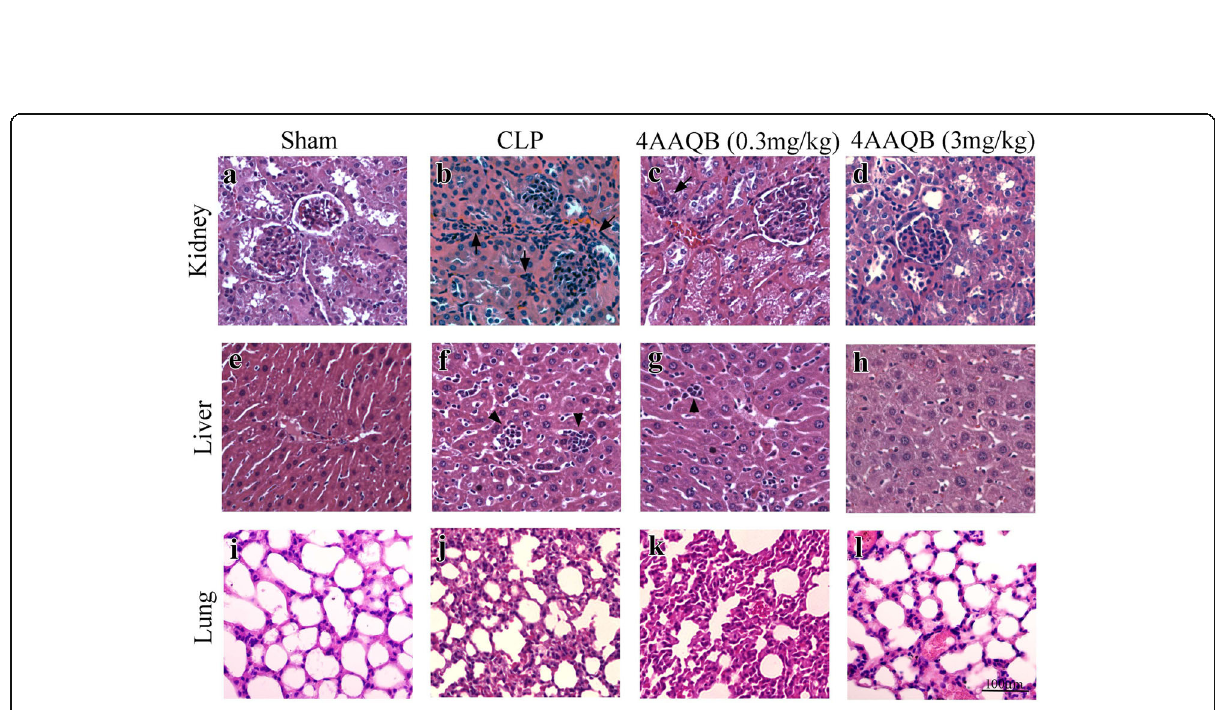
Fig. 8 Protective effects of 4AAQB on tissue injury in a CLP-induced sepsis model. Morphological changes in the mouse kidney ( a - d ), liver ( e - h ) lung ( i - l ), and sections [hematoxylin and eosin ( h & e ) stain, all panels are × 400 with the same scale bar in panel L]. a , e , k control mice (Sham), b , f , j CLP-induced sepsis mice, c , g , k CLP-induced sepsis mice treated with low dose 4AAQB (0.3 mg/kg) and d , h , l CLP-induced sepsis mice treated with high dose 4AAQB (3